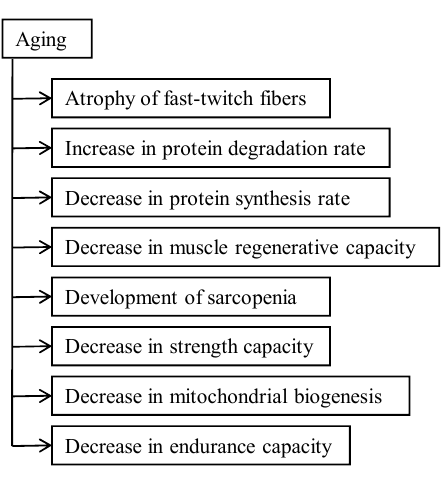
Figure 2. Effect of aging on skeletal muscle.